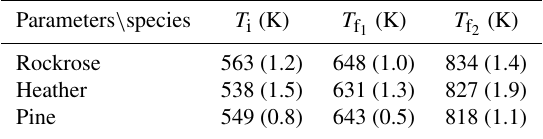
Table 2. Characteristic temperatures of thermal degradation of species at β = 30Kmin − 1